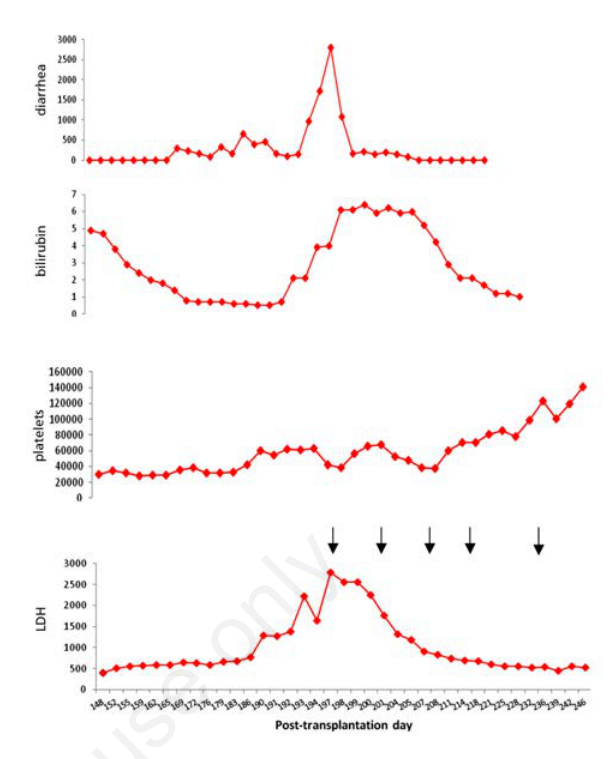
Figure 1. A) Colon biopsy with acute graft versus host disease (GVHD); B) colonic mucosa with apoptotic bodies in crypts (GVHD).